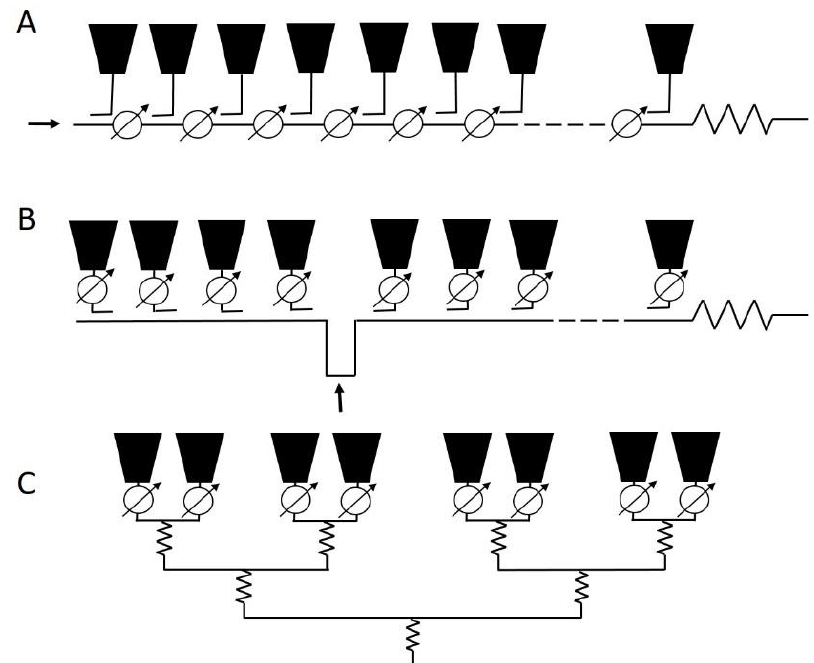
Figure 4. Sketch with regards to the applicability possibilities for the solutions with different nature: ( A ) end-fed, ( B ) center-fed, and ( C ) corporate-fed linear arrays.